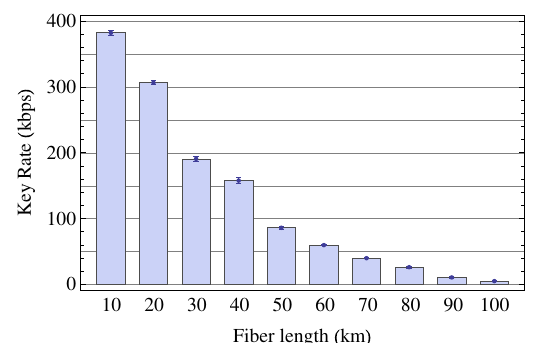
Fig. 2 The secure key rate as a function of the fi ber length when QKD is authenticated by the PQC algorithm. The values shown are the average values over 5 min. The error bar represents a standard deviation of 10 key rate values for each fi ber